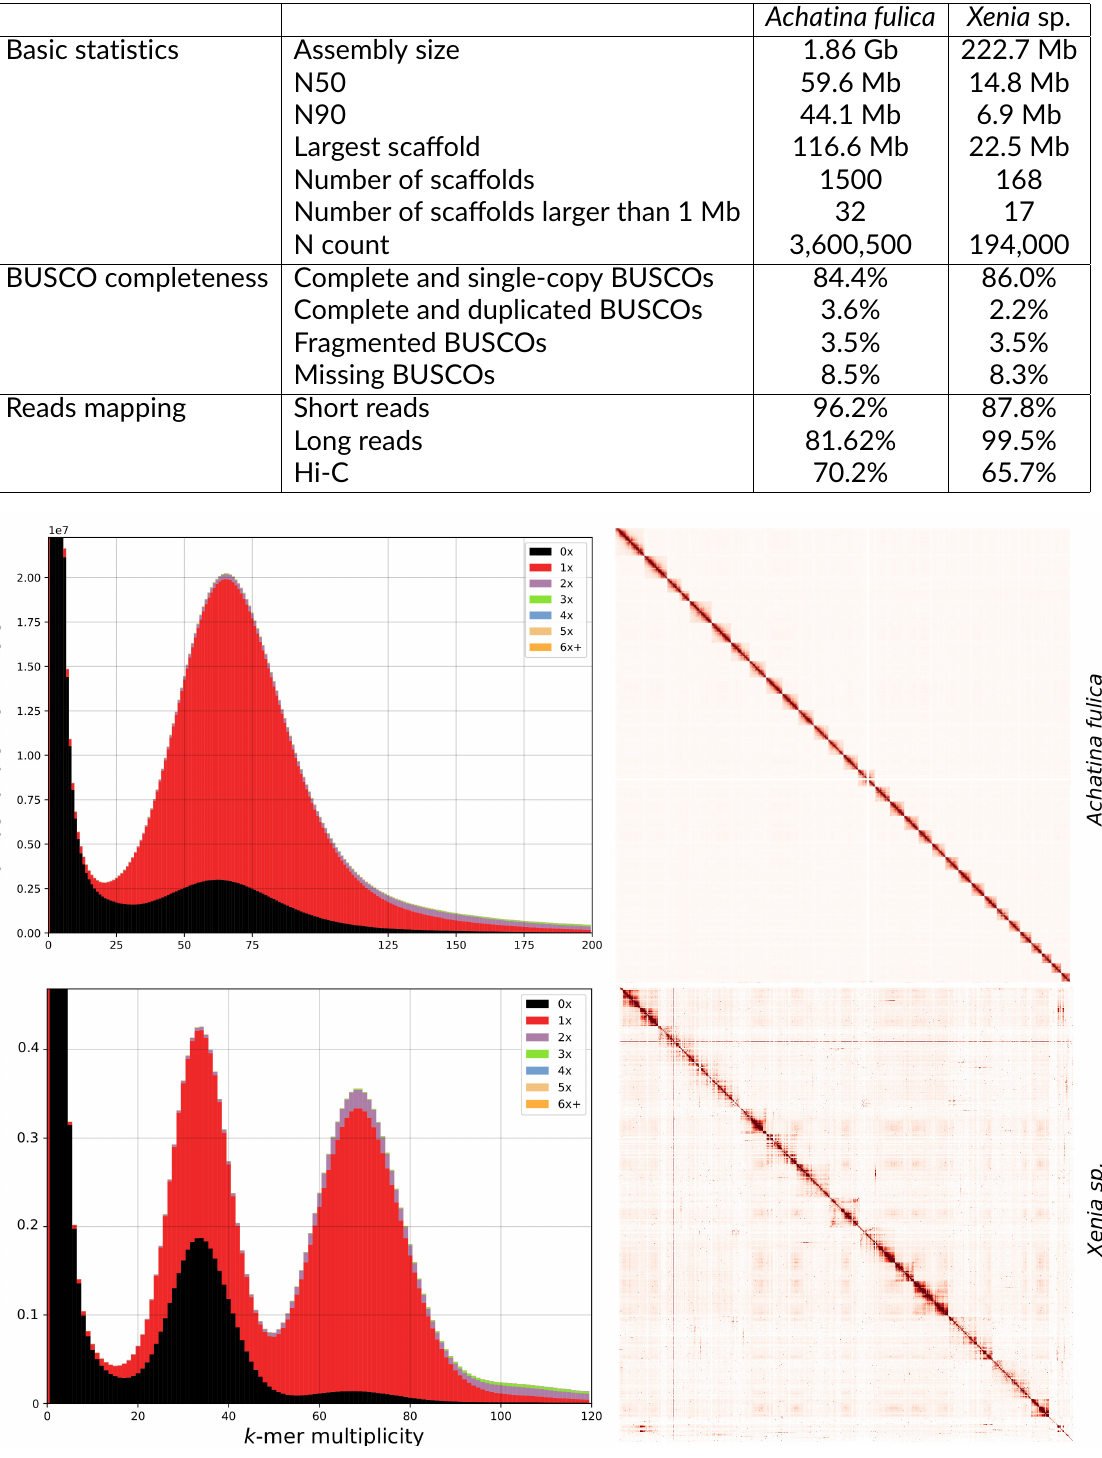
Figure 8 – Assembly evaluation of Achatina fulica and Xenia sp.. Left: KAT comparison of the k -mers in the Illumina datasets v. the assembly. Right: Hi-C contact maps, with a binning of 300 for Achatina fulica , 30 for Xenia